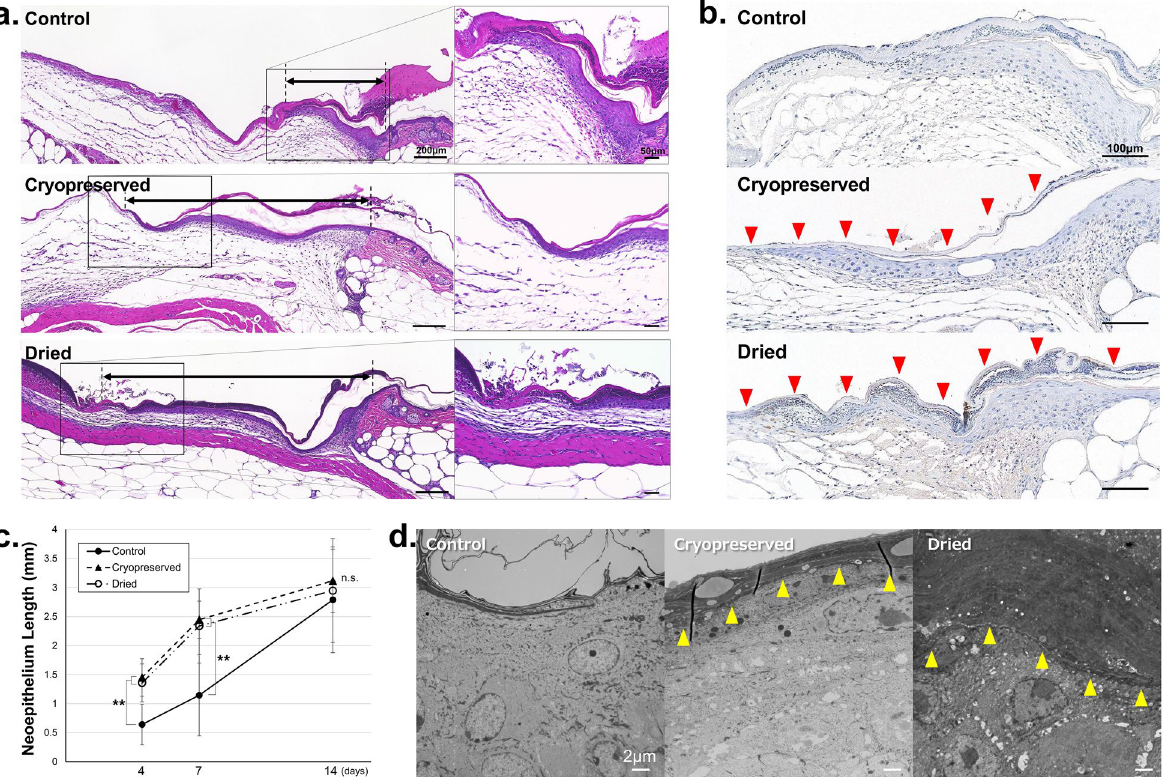
Figure 5. Microscopic images of wound areas in mice of control, cryopreserved CE, and dried CE groups. ( a ) The hematoxylin–eosin stained sections of the wounds in control, cryopreserved CE, and dried CE groups. The arrows indicate the newly formed epithelium. ( b ) Sections stained with anti-STEM121 in the wounds of control, cryopreserved CE, and dried CE groups. The red arrowheads (filled triangle) indicate cultured epidermis. The recipient murine keratinocytes can be easily distinguished from the transplanted CE. ( c ) Length of the epithelium in the wounds in control, cryopreserved CE, and dried CE groups. The epithelial lengths of the two CE groups were significantly higher than those of the control group on days 4 and 7, and significant difference was not observed between the two CE groups. Significant differences between the groups were not observed on day 14. (** P < 0.01, n = 6). ( d ) Transmission electron microscopy (TEM) images of the wound edge in control, cryopreserved CE, and dried CE groups. The wounds were harvested on day 2 and observed using TEM. The yellow arrowheads (filled triangle) indicate the boundary between the implanted CE and recipient keratinocytes. The transplanted human CE and the cell membrane of the mouse keratinocytes completely adhered without any gaps. CE, cryopreserved